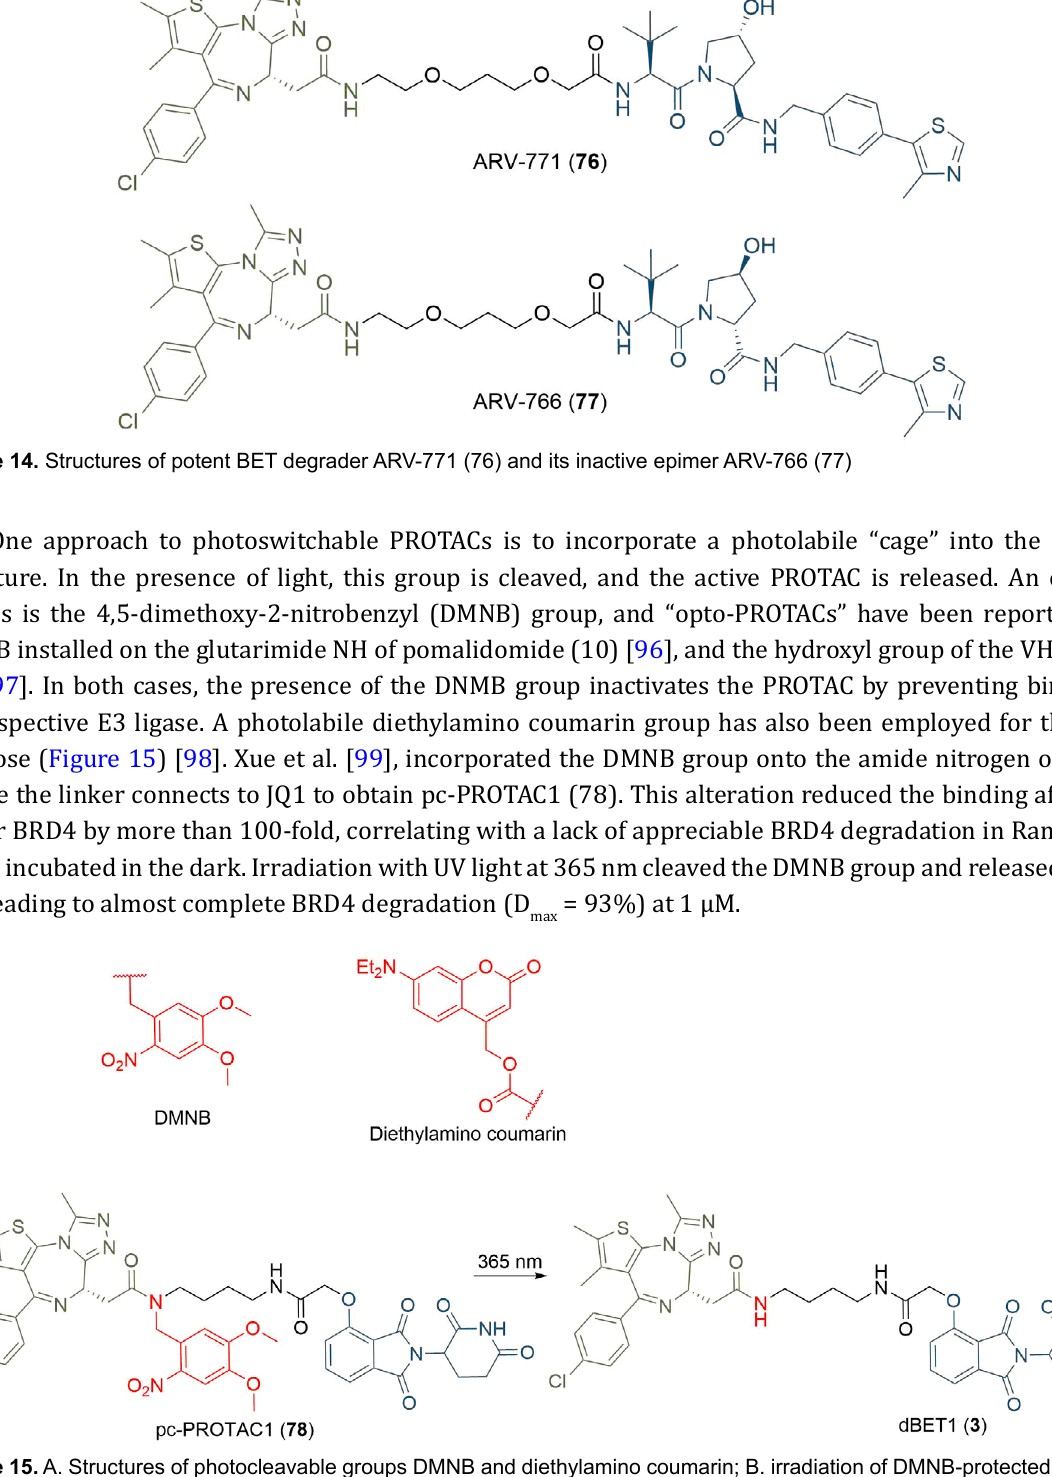
Explor Target Antitumor Ther. 2020;1:273-312 | https://doi.org/10.37349/etat.2020.00018